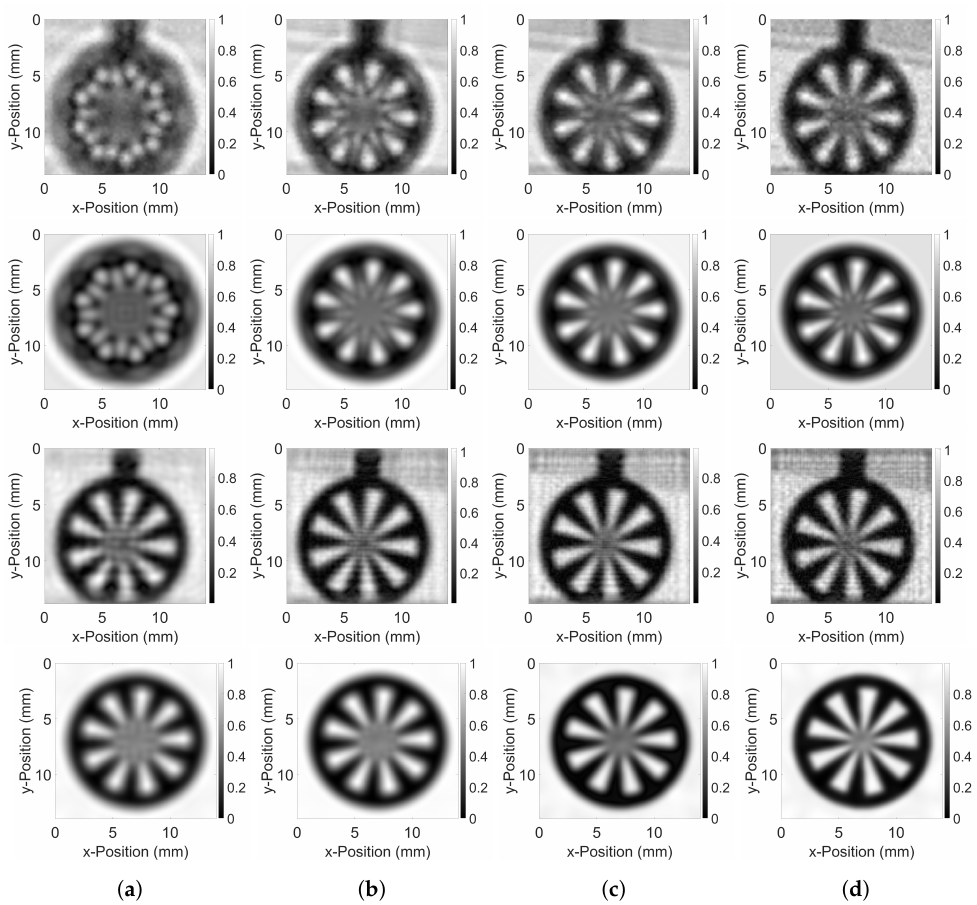
Figure 7. Resolution target images at distance ∆ z = 5 mm from mask: measurement: (first row), and simulations (second row); holographic reconstruction of measurements (third row) and holographic reconstruction of simulations (fourth row); ( a ) 0.5 THz; ( b ) 1.0 THz; ( c ) 1.5 THz; ( d ) 2.0 THz. Measurements and simulations are again in good agreement. Back propagation of the complex images taken at ∆ z = 5 mm to the sample position at z = 0 mm yields a good reconstruction of the original target, as shown in the third and fourth row in Figure 7.